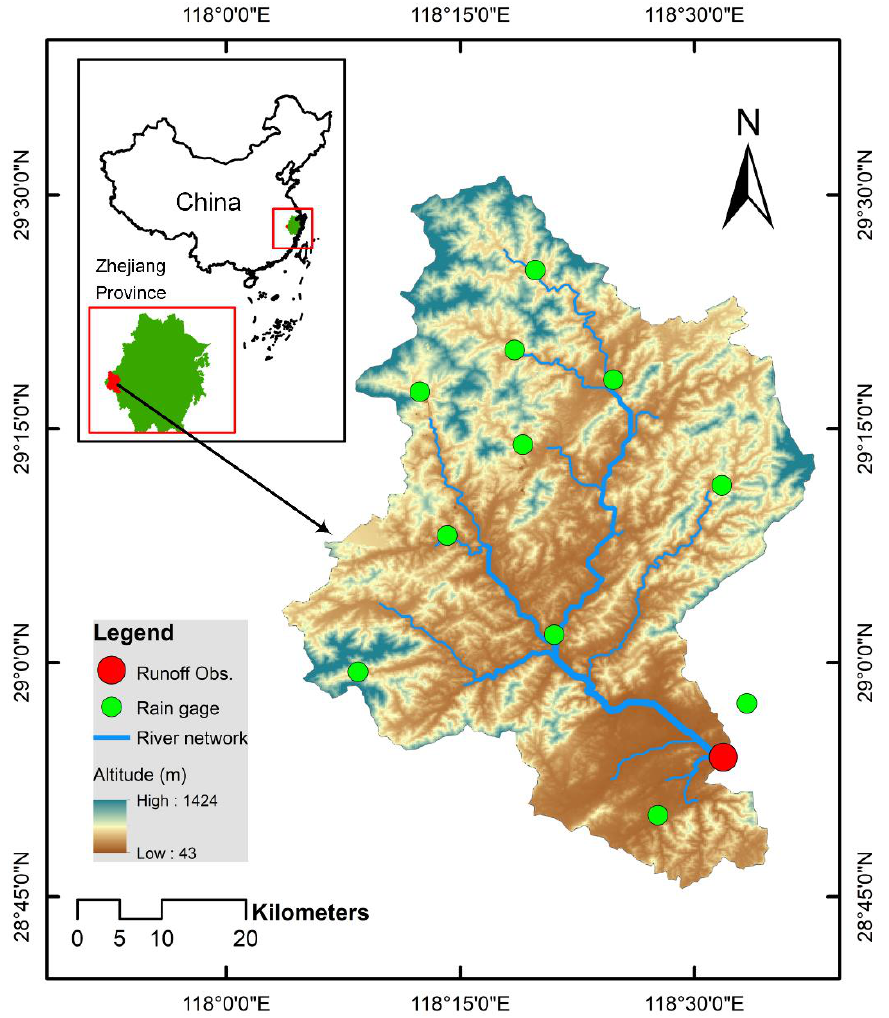
Figure 1. Map of the Changshangang River Basin. Rain gages are shown with green circles, and runoff observations are collected from the Changshangang station (red circle).